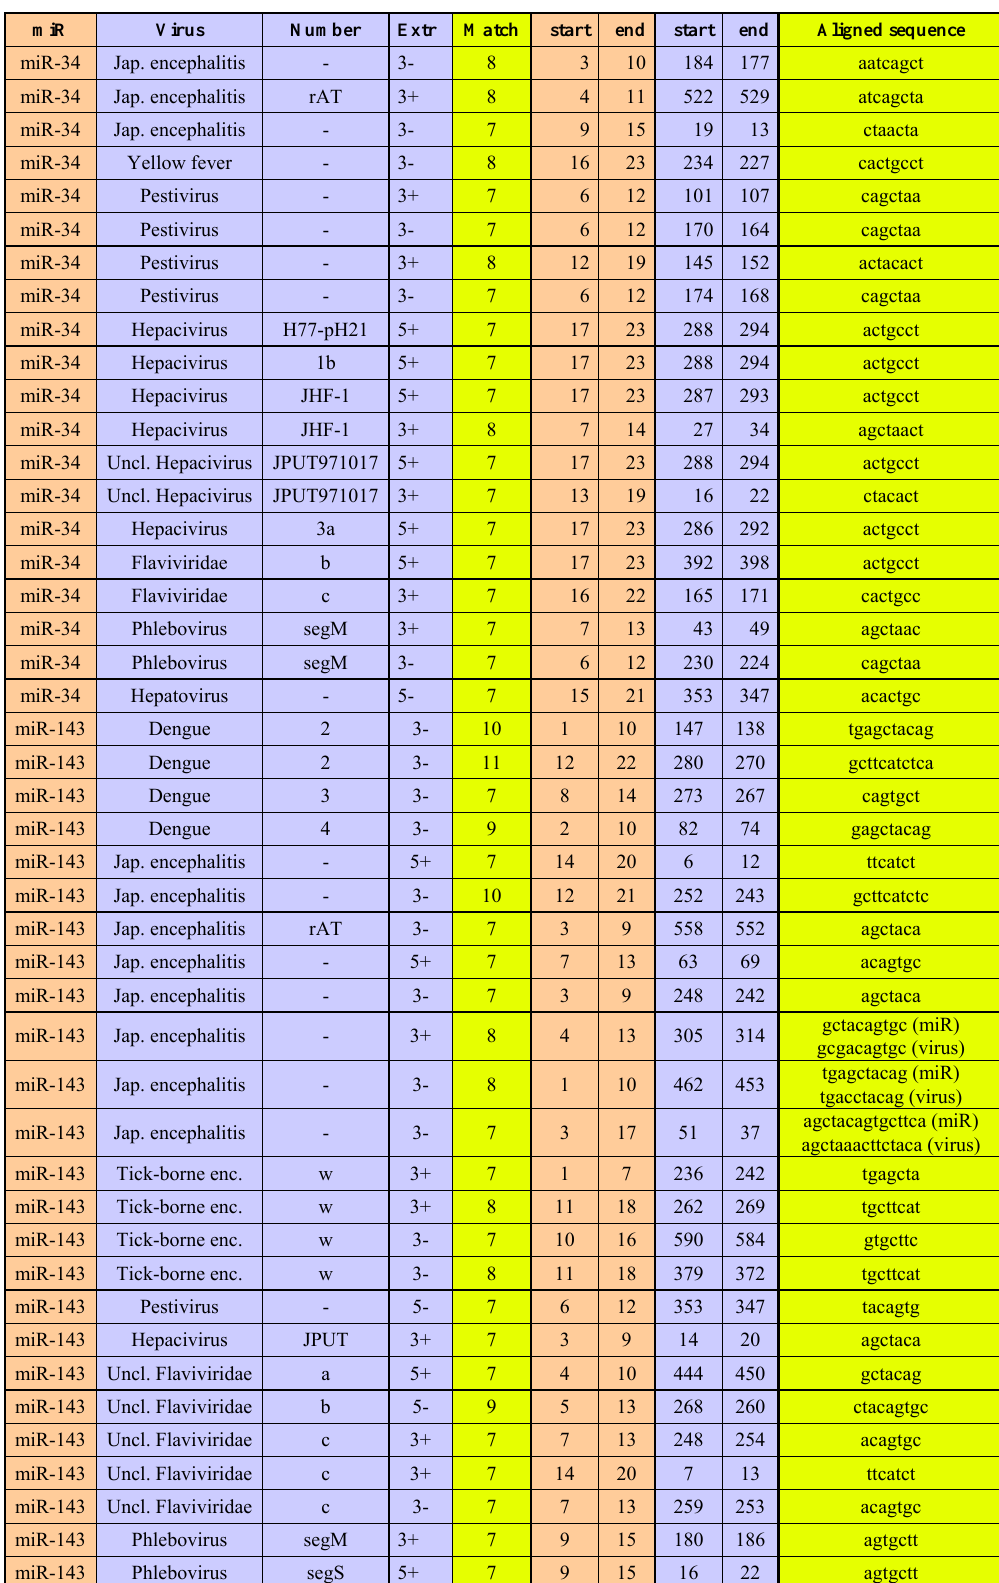
Table 1. Perfect matches ≥ 7 (green) between miR-34, miR-143 and eight